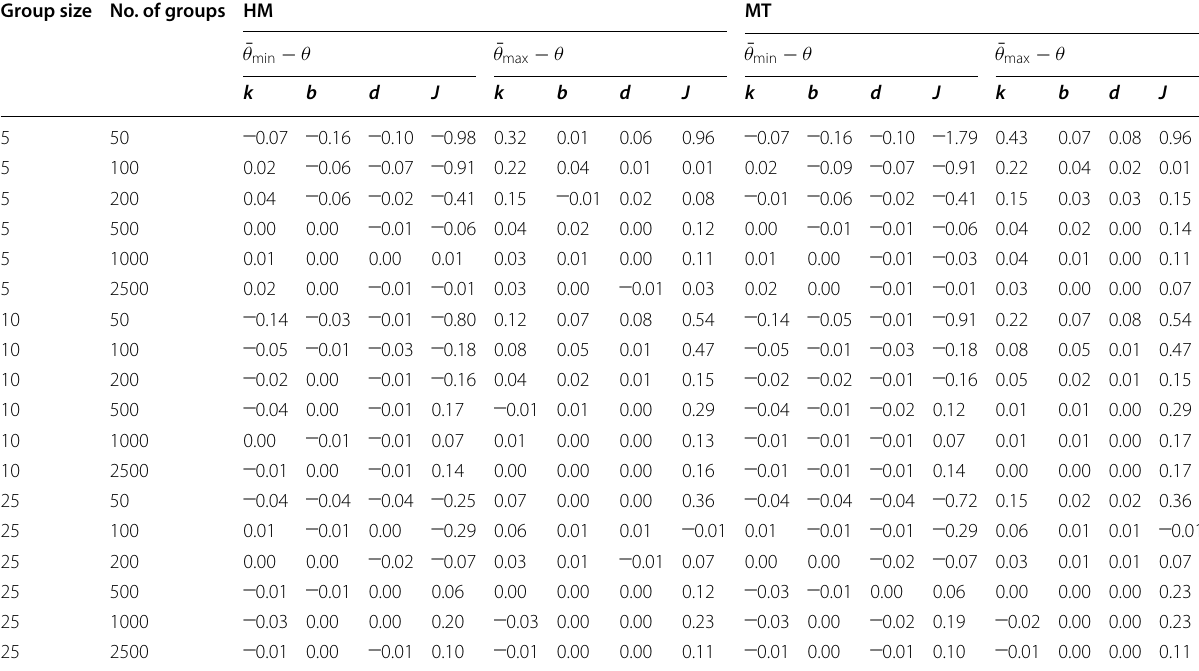
50 Monte Carlo simulations, 5 missing values in each simulation